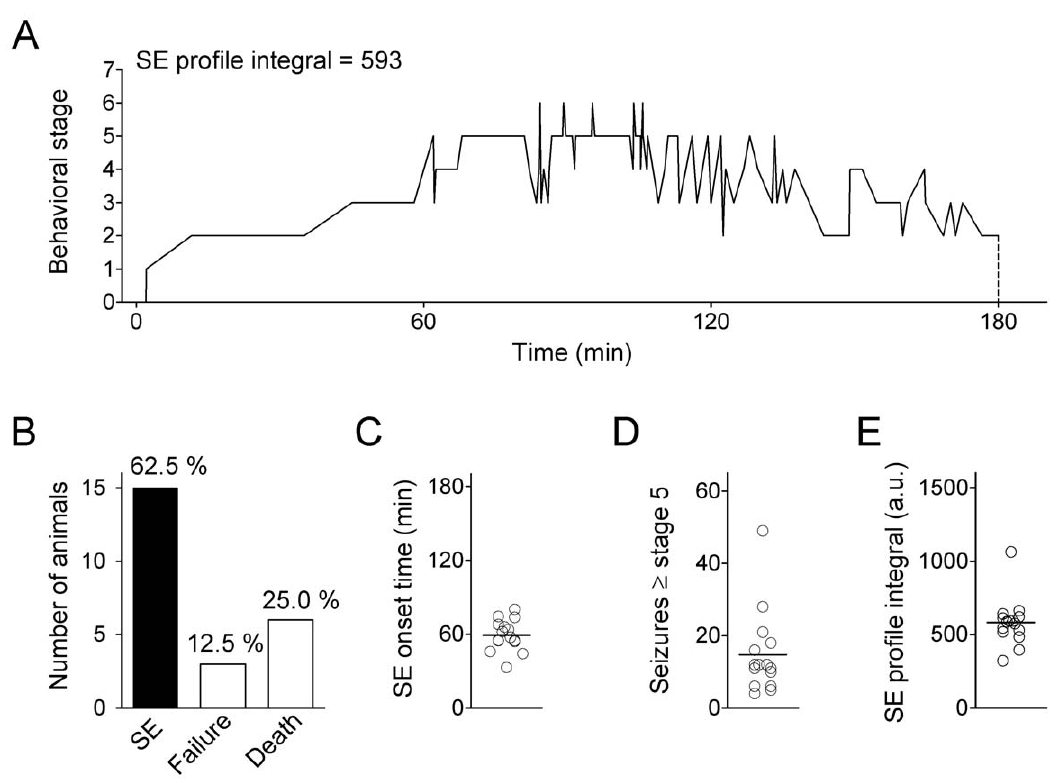
Figure 1. Monitoring status epilepticus induction in mice. Status epilepticus (SE) was induced by an intraperitoneal (i.p.) injection of kainate in juvenile (3 weeks old) C57BL/6 mice. A . Typical SE profile (behavioral stage transitions over time); kainate was injected at time point 0, and the animal was sacrificed after 180 min). Behavioral analysis was based on an 8 point scale (0 to 7; see Methods). SE severity was quantified by the SE profile integral (area under SE profile curve between 0 and 180 min, number in arbitrary units; see Methods). B . Rate of successful SE induction (n=15), failure (n=3) and death (n=6) within the group of all kainate-injected animals (n=24). C . SE onset time (time until stage 5 was first reached, n=15). D . Number of seizures $ stage 5 (n=15). E . SE profile integral (a.u., arbitrary units; n=15). Mean values are indicated by horizontal